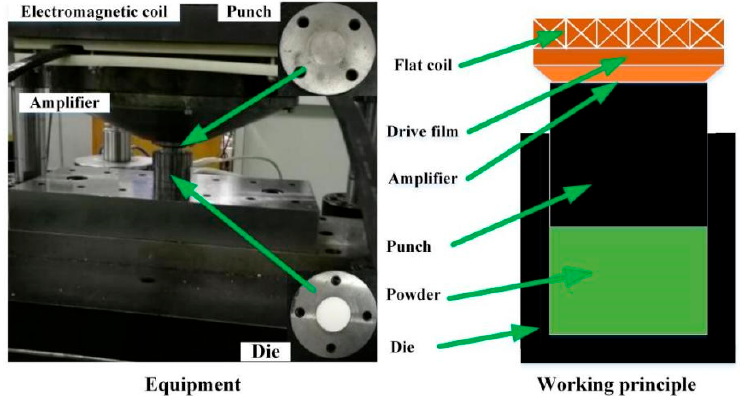
Figure 7. Electromagnetic assisted powder compaction